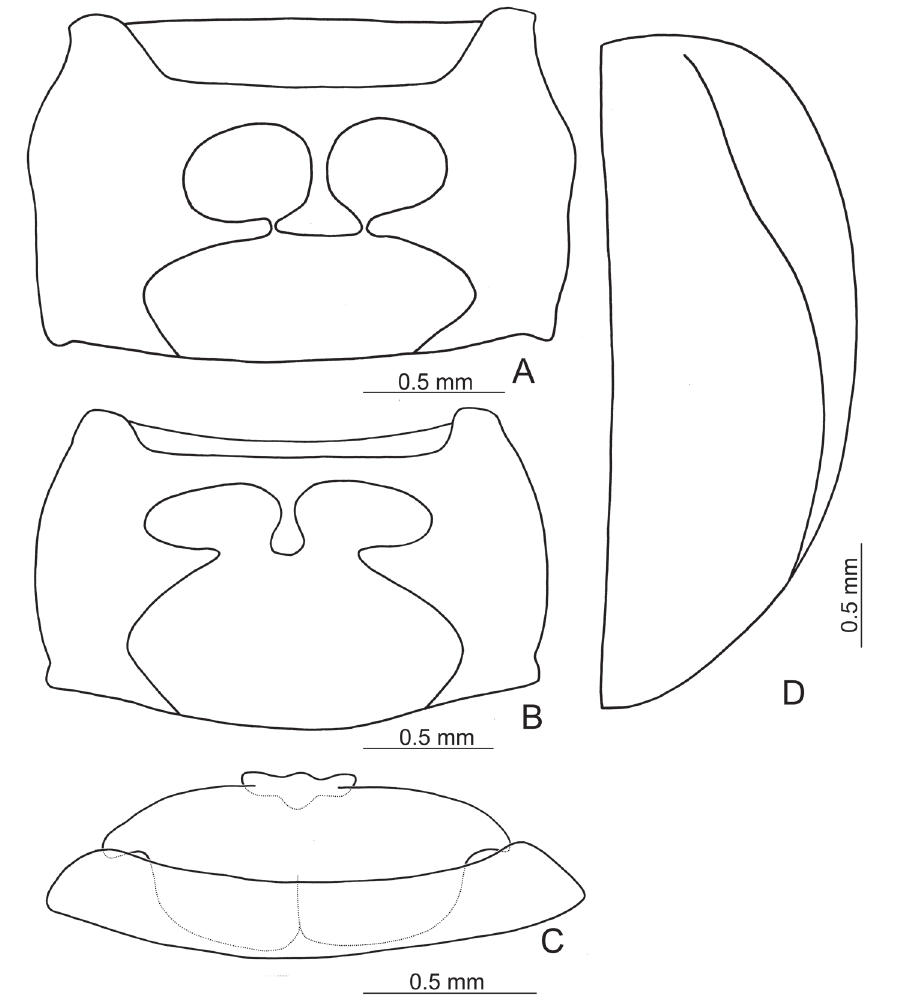
Figure 2. Generic characters for Taiwanoshaira . A prothorax, ventral view, T. taipingshanensis sp. nov. B prothorax, ventral view, T. tsoui sp. nov. C last two abdominal ventrites, dorsal view, male, T. tsoui sp. nov. D elytron, ventral view, T. tsoui sp.